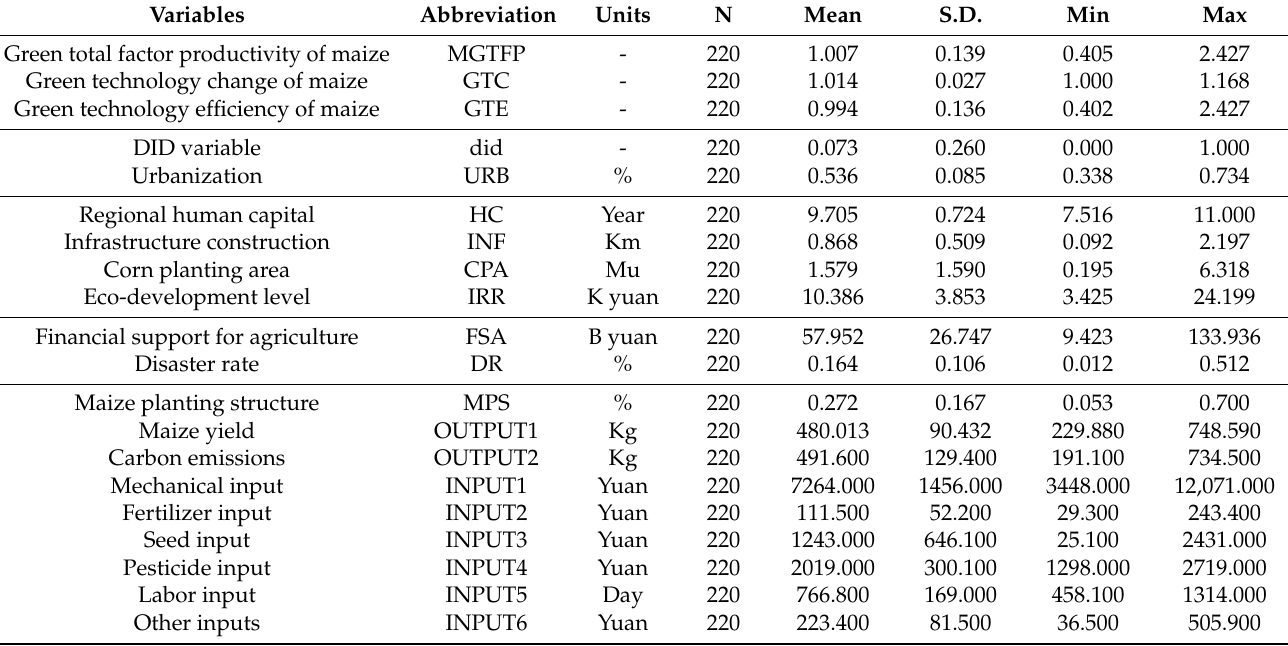
Table 2. Descriptive statistics of